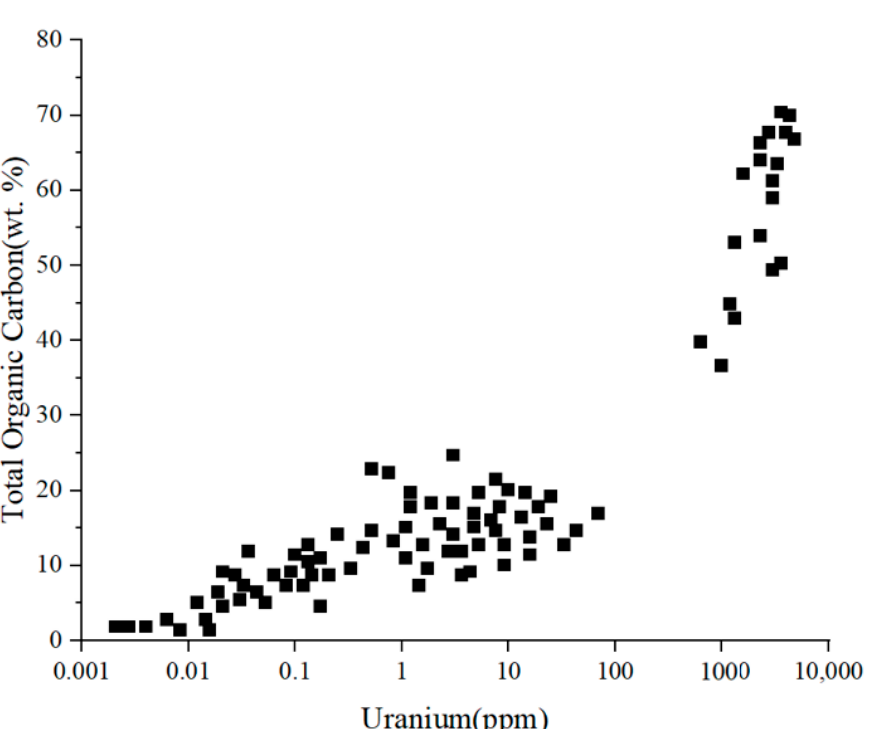
Figure 5. Correlation between uranium and TOC (quoted from Schulz et al. [125]) .